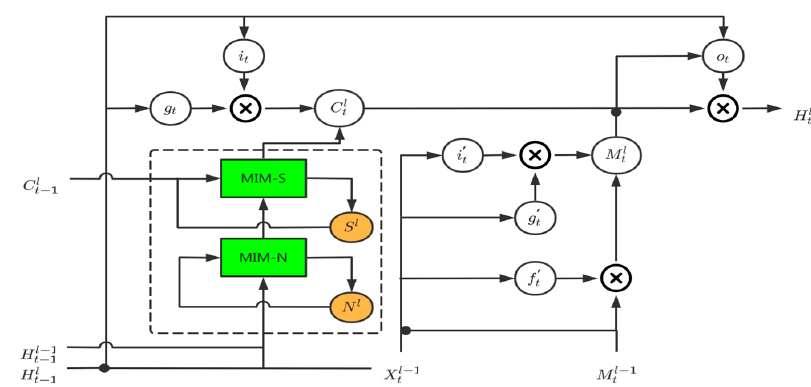
Figure 4. MIM block.